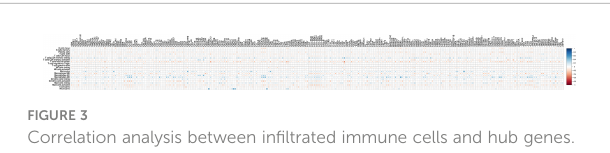
FIGURE 3 Correlation analysis between in fi ltrated immune cells and hub genes.